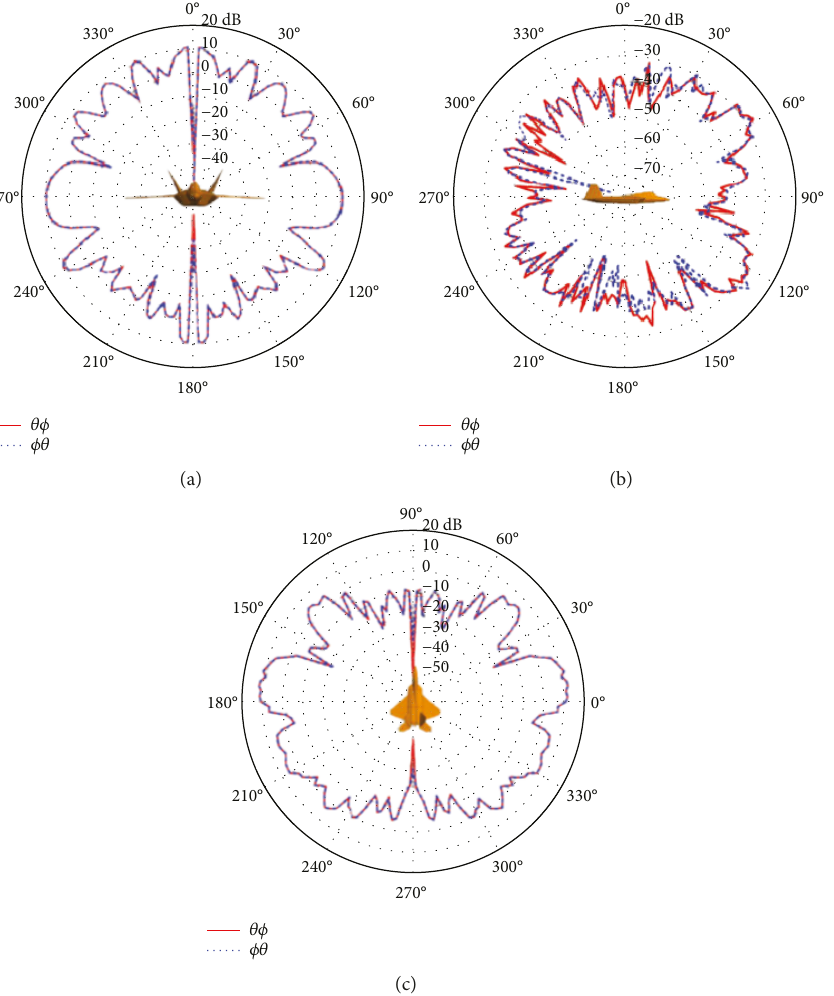
Figure 4: Monostatic RCS of an aircraft for cross polarization. (a) xz plane. (b) yz plane. (c) xy